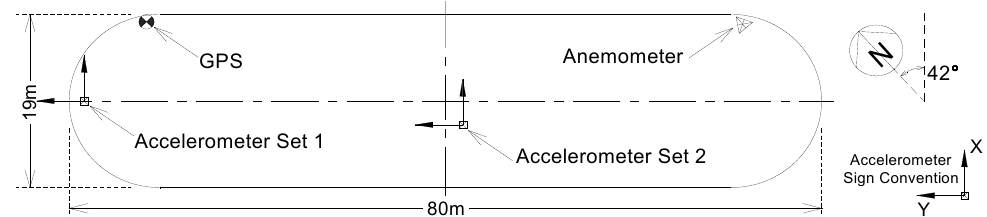
Figure 8. Plane view of test building and field measurement configuration.